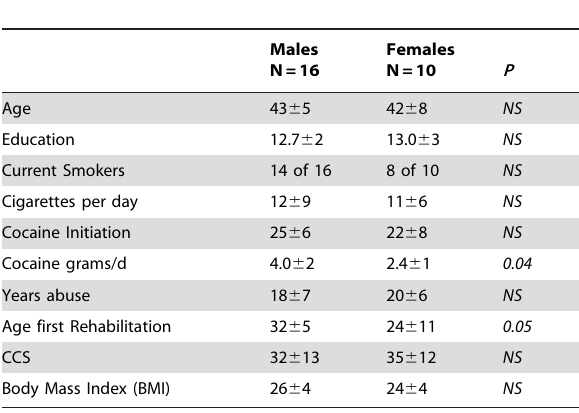
Table 3. Demographic and clinical characteristics of